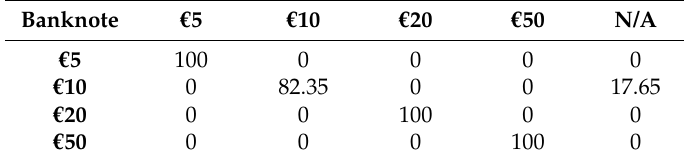
Table 4. Euro banknote recognition in an indoor environment at a distance of 38 cm,